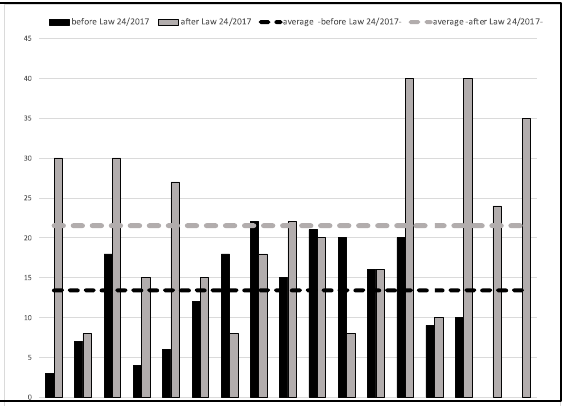
Figure 1. Assessment of biological damage before/after Law